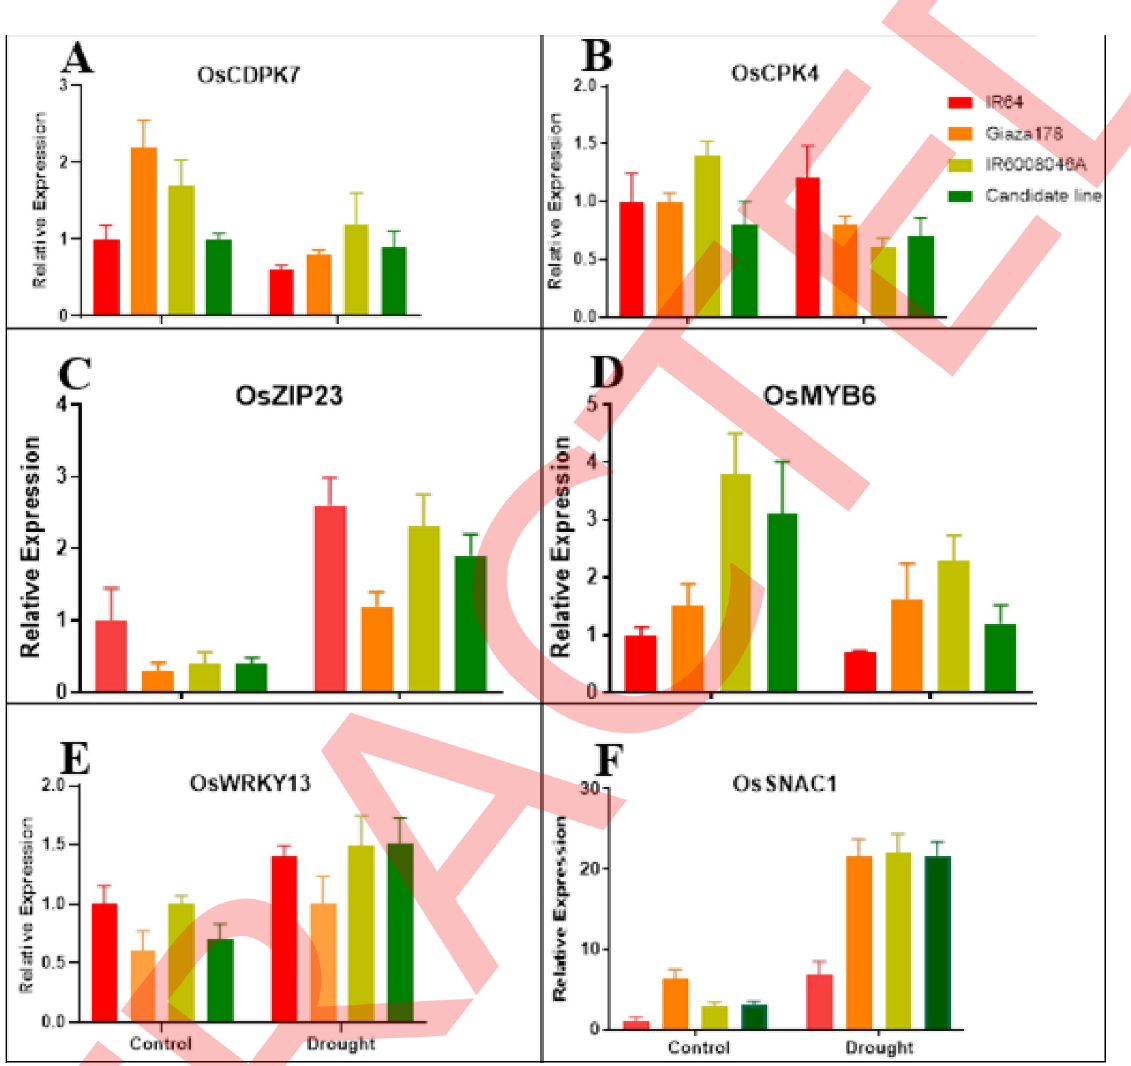
Fig 7. The expression level of OsCDPK7 (A), OsCPK4 (B), OsZIP23 (C), OsMYB6 (D), OsWRKY13 (E) and OsNAC1 (F) under normal and drought stress conditions. Data are represent as means ± SEM (n = 6). expressional level of OsCDPK7 was down regulated in all genotypes with a slight reduction in the candidate line RBL-112 in response to drought-stress (Fig 7A). This result indicates that OsCDPK7 has not major role in drought response in the studied genotypes. Similarly, the tran- scription levels of OsCPK4 (a member of calcium-dependent protein kinases) was slightly up- regulated in IR64, repressed in the tolerant parent IR6008046A, and slightly down-regulated in the candidate line RBL-112 and the Giza-178 under drought (Fig 7B). These results indicate that the OsCPK4 gene has no role in drought tolerance in neither IR6008046A nor the candi- date line RBL-112. The transcription level of OsZIP23 was the highest in sensitive chick IR64, while it was poorly expressed in the other genotypes under normal growth conditions. Mean- while, the transcript level of OsZIP23 was up-regulated in the four studied genotypes due to drought-stress (Fig 7C). The current data in (Fig 7D) displays that OsMYB6 gene was highly repressed in the candidate line RBL-112 and the tolerant parent IR6008046A. It was slightly down-regulated in the susceptible check IR64, but it was none significantly induced in the